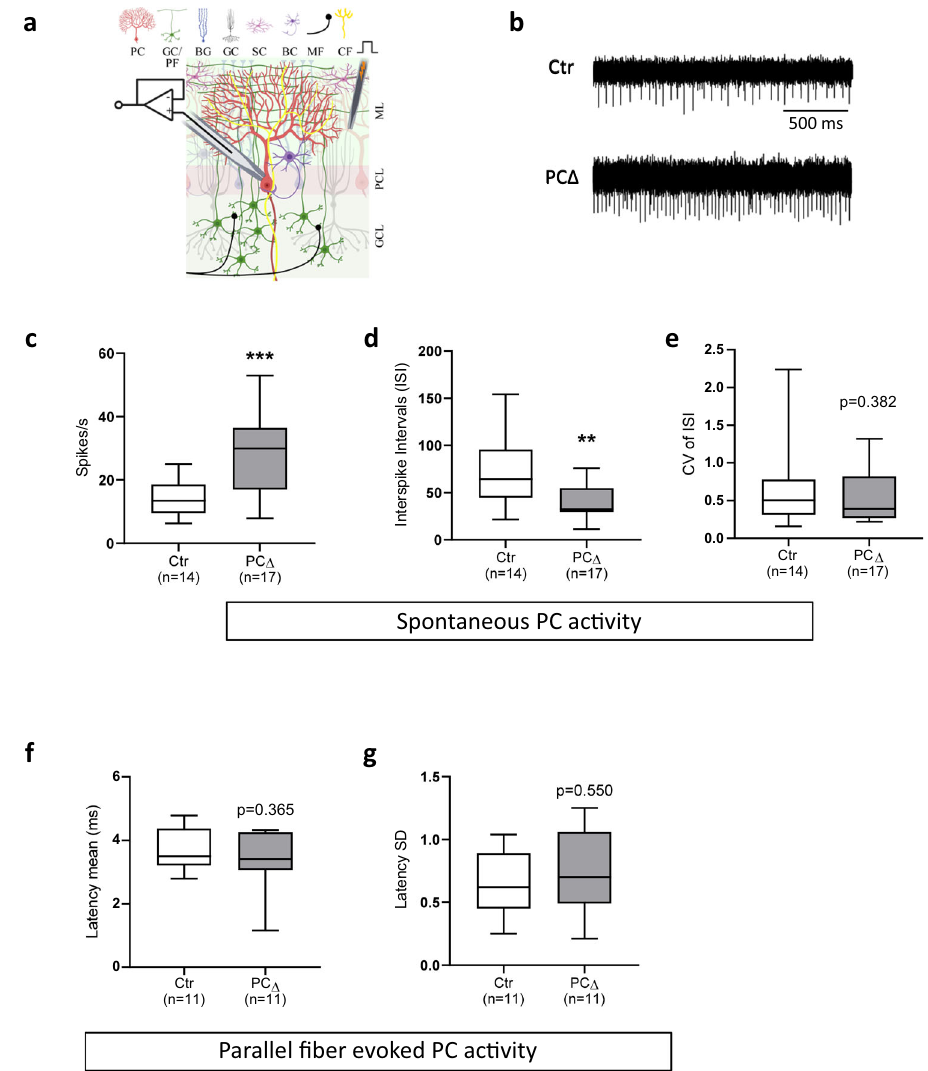
Fig. 2 ATR-PC Δ neurons have abnormal intrinsic activity. a Schematic representation of cerebellar loose-patch electrophysiology measurements on Purkinje cell soma and stimulation of parallel fi ber-Purkinje cells synapses. PC Purkinje cell, GC/PF granule cell with parallel fi bers, BG Bergmann glia, GC Golgi cell, SC stellate cell, BC basket cell, MF mossy fi ber, CF climbing fi ber. b Sample traces from the passive activity recordings of Purkinje cells of controls (Ctr) and ATR-PC Δ (PC Δ ) mice. c Passive activity as shown by spikes/s revealed increased spiking frequency in ATR-PC Δ neurons. p < 0.001. d Interspike intervals (ISI in ms). The ISI includes only spikes with intervals <2s. p = 0.006. e The coef fi cient of variance (CV) of ISI. CV of ISI is an indicator for the reliability of the cells ’ tonic fi ring. p = 0.382. f The fi ring latency measured from the evoked spike to next spike (in ms). p = 0.365. g The standard deviation (SD) of this latency between all sweeps of one recorded cell. p = 0.550. MWU test (unpaired, two-tailed) is performed for the statistical analysis. ** p < 0.01, *** p < 0.001. The number of neurons measured is indicated within the graph. Box plots in ( c – g ) indicate the median (middle line), whiskers as max value (top) and min value (bottom) and hinges as 25 percentile (top) and 75 percentile (bottom). Source data are provided as a Source Data fi